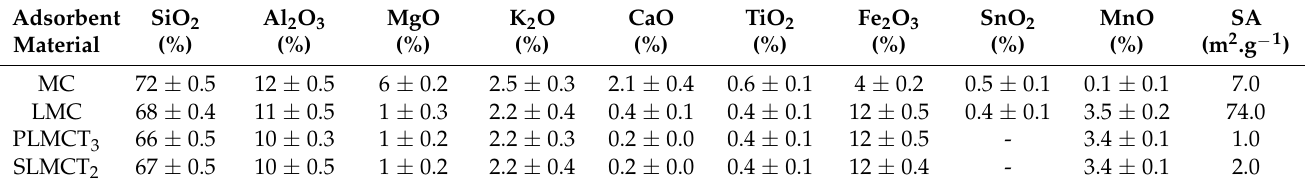
Table 1. Chemical composition a (weight %) and specific surface area (m 2 /g) of adsorbents.